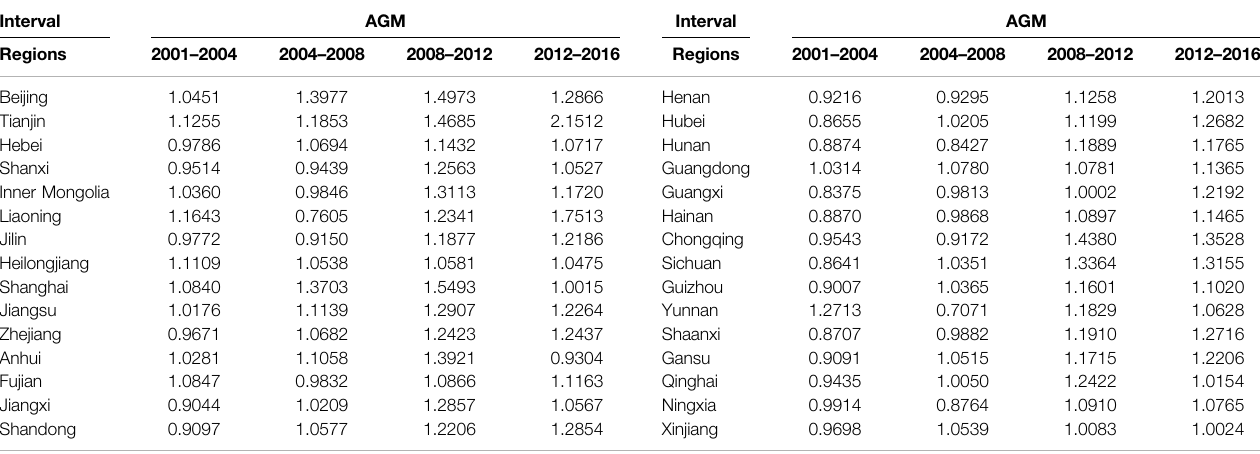
TABLE 3 | The dynamic change of eco-ef fi ciency of China ’ s 30 provinces in different periods. Interval AGM Interval